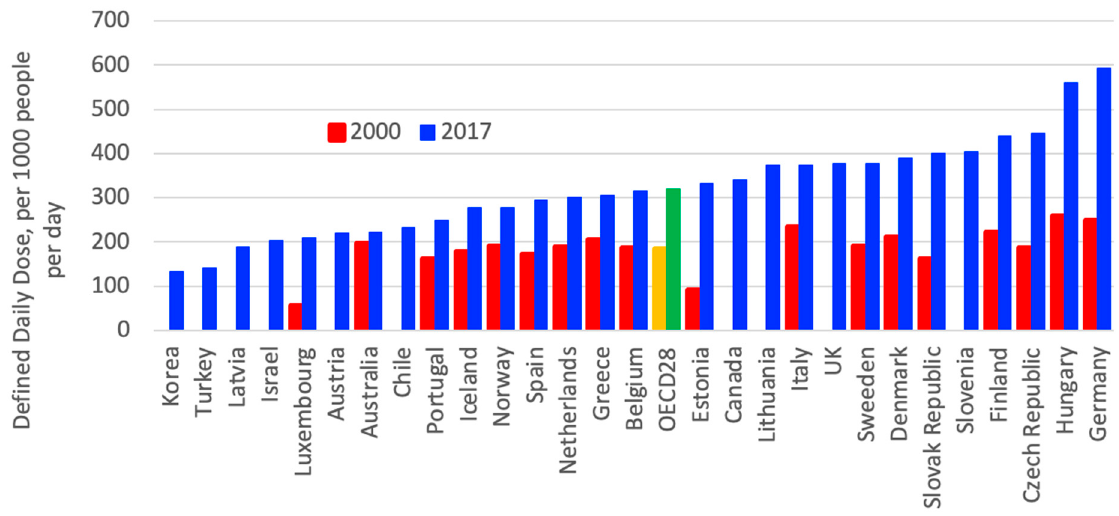
Figure 9. Consumption of antihypertensive pharmaceuticals in OECD countries from 2000 to 2017 [3]. The use of antidiabetic drugs approximately doubled in OECD countries between 2000 and 2017; Finland, the Czech Republic, Canada, UK, Germany, and Slovenia have the highest consumption, as shown in Figure 10. This increasing consumption can be explained by the increasing prevalence of diabetes and obesity [3].